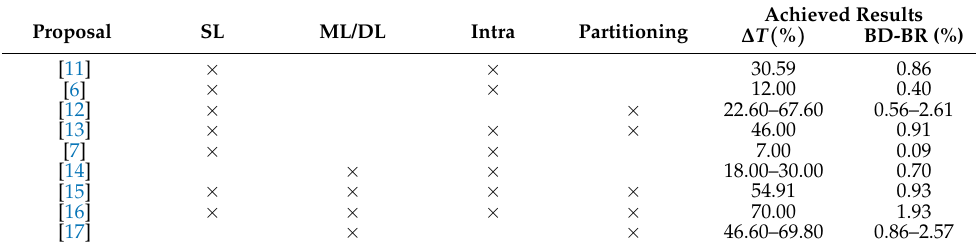
Table 1. Previous